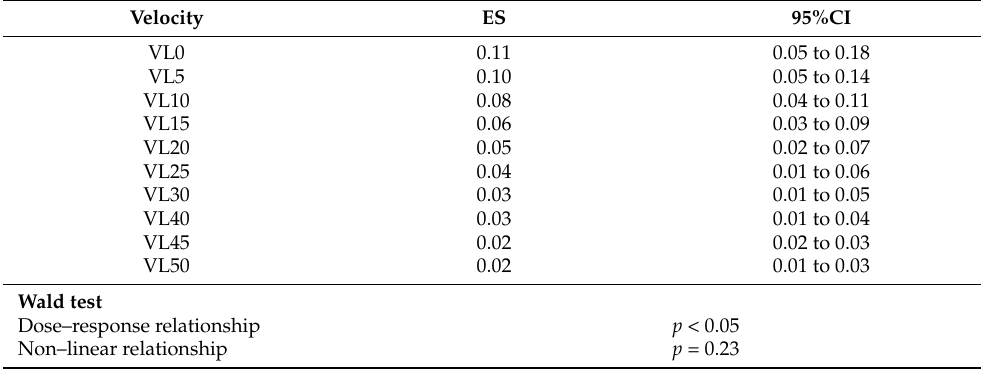
Figure 3. The dose–response curve of the maximum strength gain per repetition. Table 5. The dose–specific effects of velocity loss on the maximum strength gain per repetition and the model